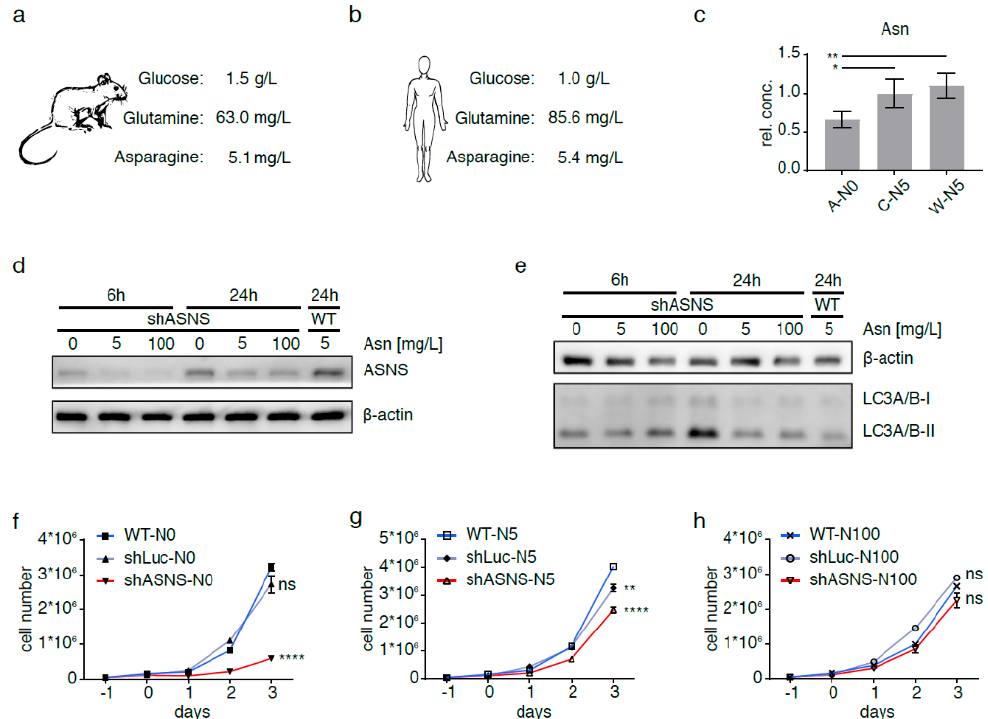
Figure 2. Asparagine depletion in mouse sarcoma cells. Physiological glucose, glutamine and asparagine concentrations in ( a ) mouse and ( b ) human plasma. Intracellular asparagine was depleted in mouse sarcoma cells by abrogating asparagine synthesis via shRNA-mediated ASNS knockdown and culture in asparagine-free medium (A-N0). ( c ) Reduction in intracellular asparagine content in A-N0 cells to <66% of that in shLuc (C-N5) and wild-type (W-N5) sarcoma cells grown in medium containing near-physiological (5 mg/L) asparagine. ( d ) Minimal ASNS expression in shASNS cells cultured in medium with 5 mg/L or excess (100 mg/L) asparagine; upregulation of ASNS expression in shASNS cells grown in asparagine-free (0 mg/L) medium. Raw data please see Figure S8. ( e ) Increased processing of LC3I/II in shASNS cells grown in asparagine-free medium for 6 and 24 h. Raw data please see Figure S9. ( f – g ) The growth of shASNS sarcoma cells (red line) was significantly reduced compared to the growth of wild-type cells (blue line) and shLuc control cells (gray line) ( f ) in asparagine-free medium and ( g ) in medium containing 5 mg/L asparagine. ( h ) In medium containing excess asparagine, shASNS and wild-type sarcoma cells grew equally well. Please see Figure S1 for asparagine content of cells measured by LC-MS. Please see Figure S2 (Raw data in Figure S10) and Figure S3 for the impact of asparagine starvation on proliferation, apoptosis and autophagy of mouse sarcoma cells in the context of high, physiological and low glutamine (584.6, 73.1 and 7.3 mg/L, respectively) and high and low glucose (4.5 and 0.5 g/L, respectively) concentrations. Data were evaluated for statistical significance by one-way ANOVA with Tukey’s post-hoc test (ns p ≥ 0.05, * p < 0.05, ** p < 0.01, **** p <